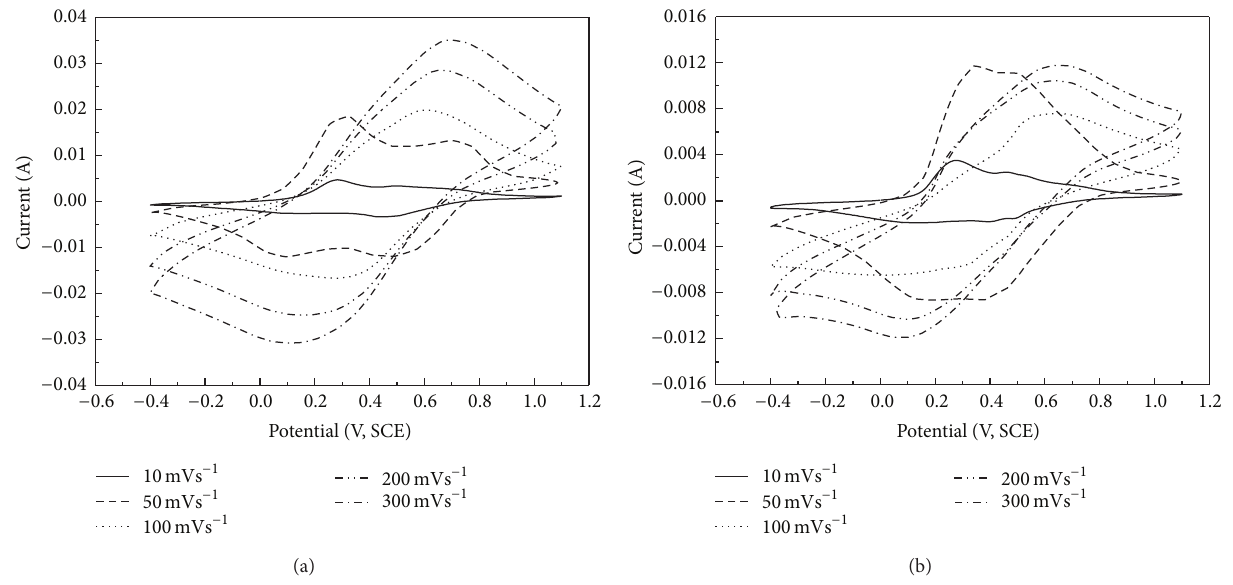
Figure 6: Cyclic voltammograms of PANI in 1MHCl (a) and 1MH 2 SO 4 (b) at different sweep rates of 10, 50, 100, 200, and 300 mVs −1 .